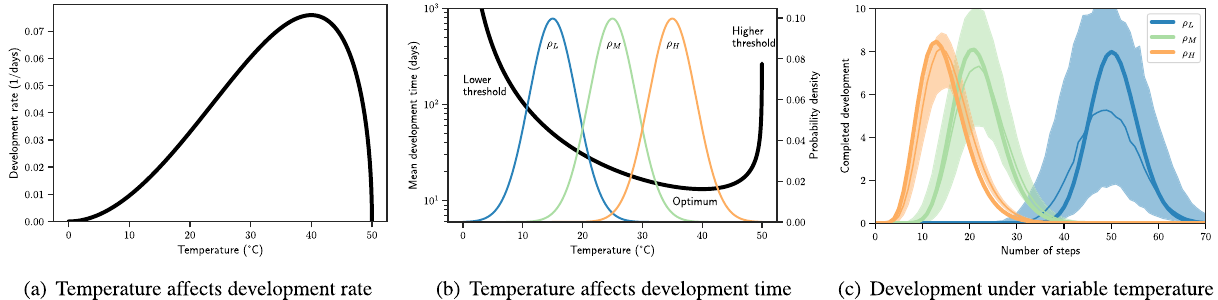
Figure 2. Development under environmental variation. In ( a ), development rate (Eq. 9) is shown with α = 1.5 × 10 − 5 , T L = 0 o C , and T H = 50 o C . In ( b ), mean development time is shown together with the probability densities of three temperature regimes ( ρ L , ρ M , and ρ H ). In ( c ), the number of individuals completing development at each step are shown with respect to the three temperature regimes. Solid lines indicate the median, shaded areas indicate the 90% range of 1000 simulations, and thick lines indicate simulations with the expected values of each